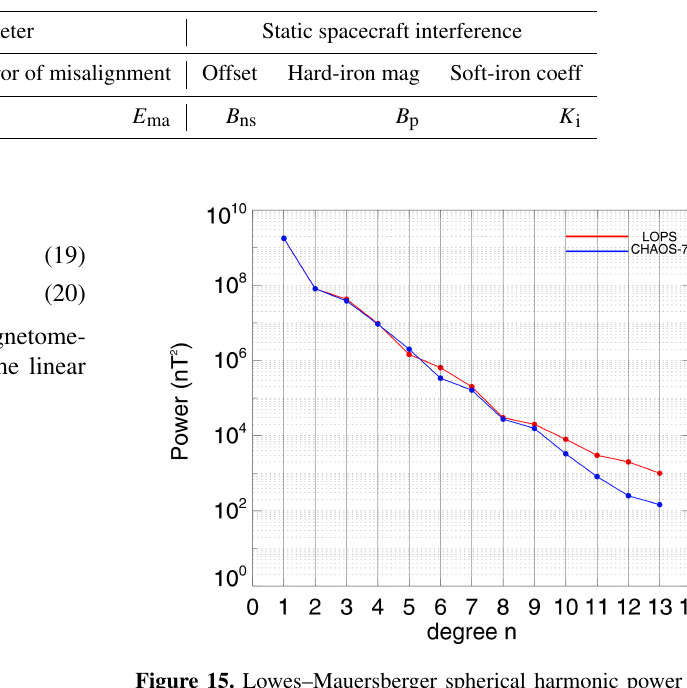
Figure 15. Lowes–Mauersberger spherical harmonic power spec- tra up to degree n = 13 of the vector magnetic field from both the CHAOS-7 model (in blue) and the model based on LOPS data (in red) in April 2018.